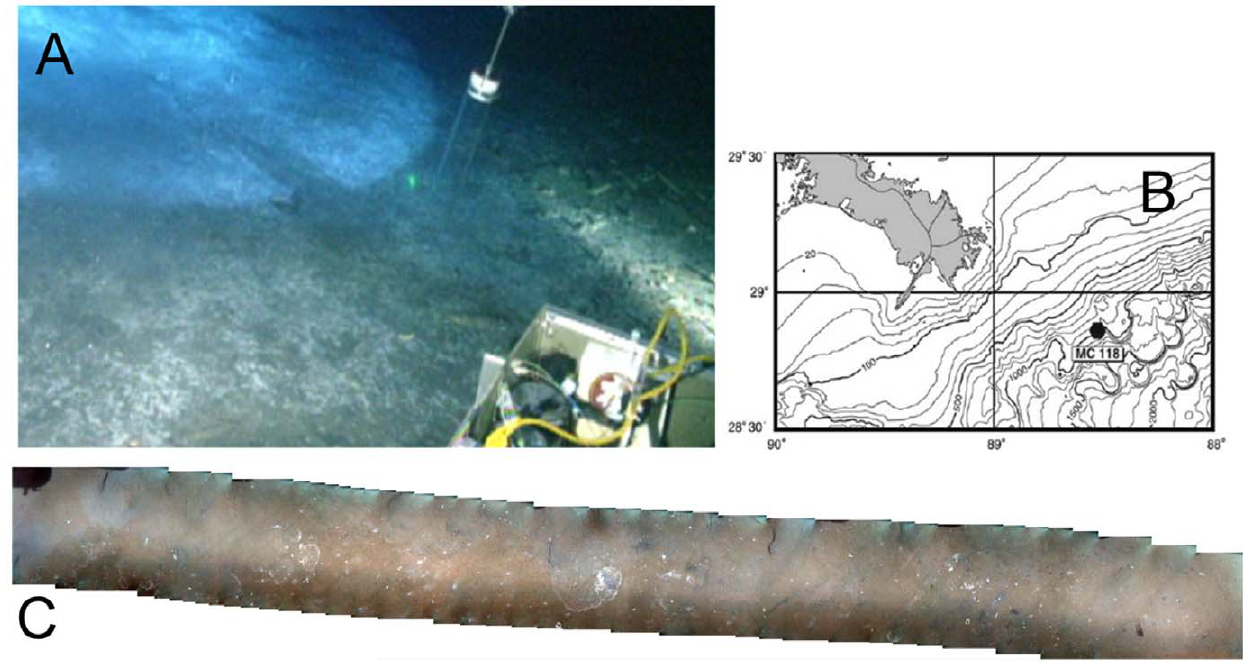
Figure 1. Locations and photos of sampling area. A) View of Beggiatoa spp. mat used for sampling. The mat covers the entire visible seafloor area of the photo; the white circle in the upper lefthand corner is the reflection of a light from the Johnson-Sea-Link submersible, B) Overview map of Mississippi Canyon block 118 (MC118) off the coast of Louisiana, and C) Mosaic image of seafloor a few tens of meters away from the large microbial mat in A; approximate width of the whole strip is 1.83 to 2.44 m given a submersible altitude of 3 to 4 m above the seafloor.